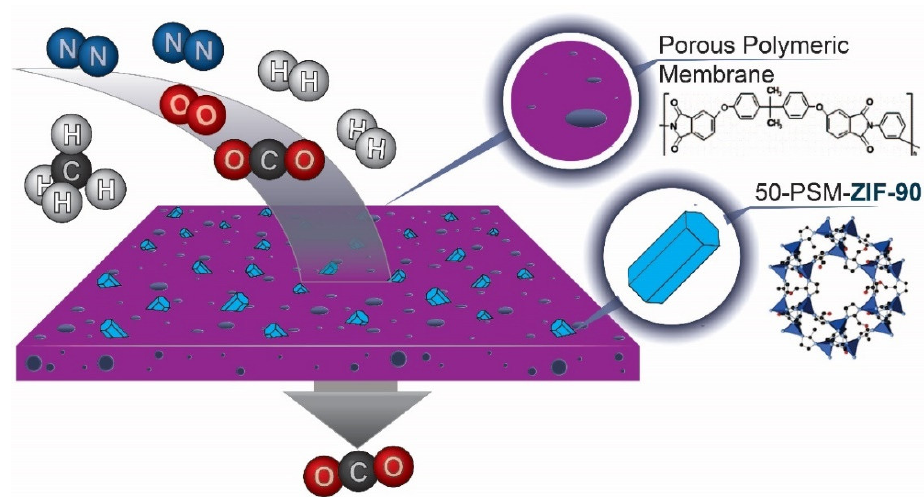
Figure 1. Schematic presentation of 50-PSM-ZIF-90-PEI membranes in CO 2 separation.